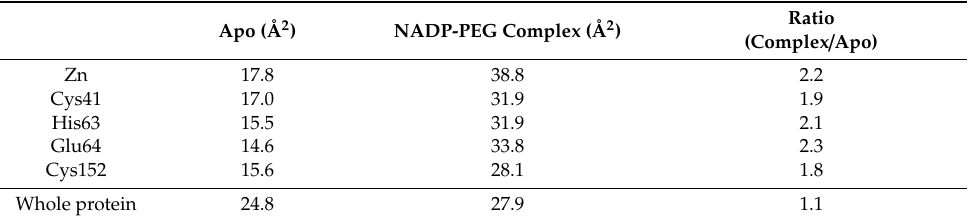
Table 2. B-factor comparisons for Zn and its coordinate